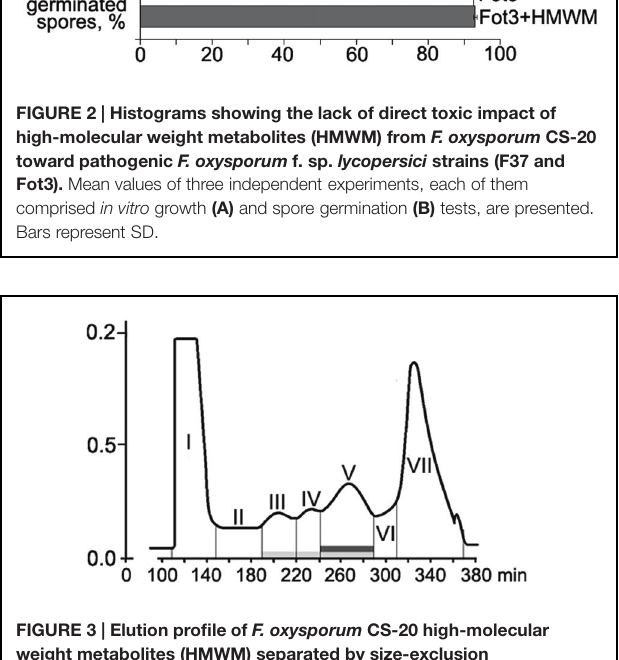
FIGURE 3 | Elution profile of F. oxysporum CS-20 high-molecular weight metabolites (HMWM) separated by size-exclusion chromatography on a column HiPrep26/60 Sephacryl S-400. Protein constituents of HMWM are indicated by a light gray box; protein-containing fraction V possessing protective activity against F. oxysporum f. sp. lycopersici is marked with a dark gray box. Fraction VII represents guanidine-HCl, which was added to a HMWM solution before the chromatographic analysis.